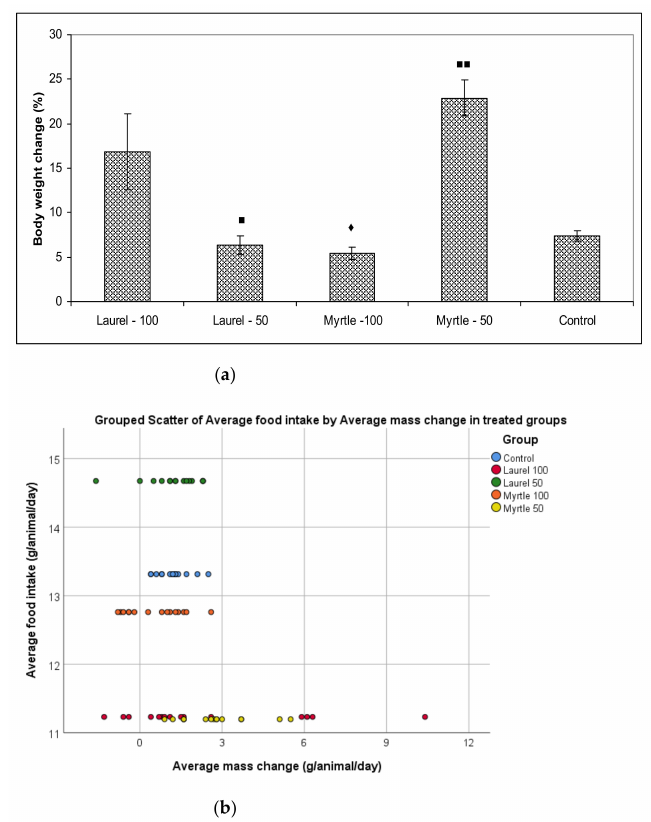
Figure 1. The effect of Laurel and Myrtle extract on body weight change during the experiment ( a ) and the scattergram of correlative relationship between average food intake and mass change